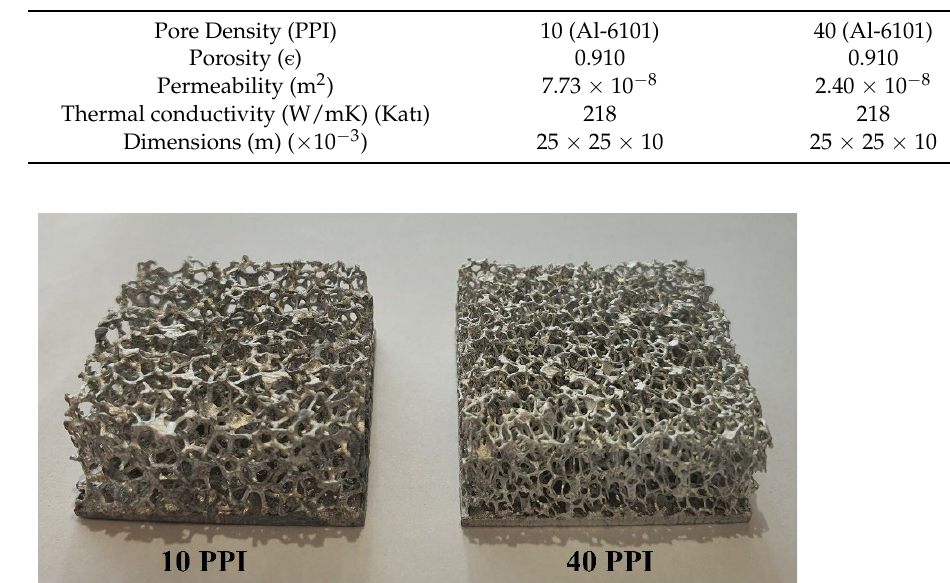
Table 1. Aluminum (Al 6061) PHSs properties.